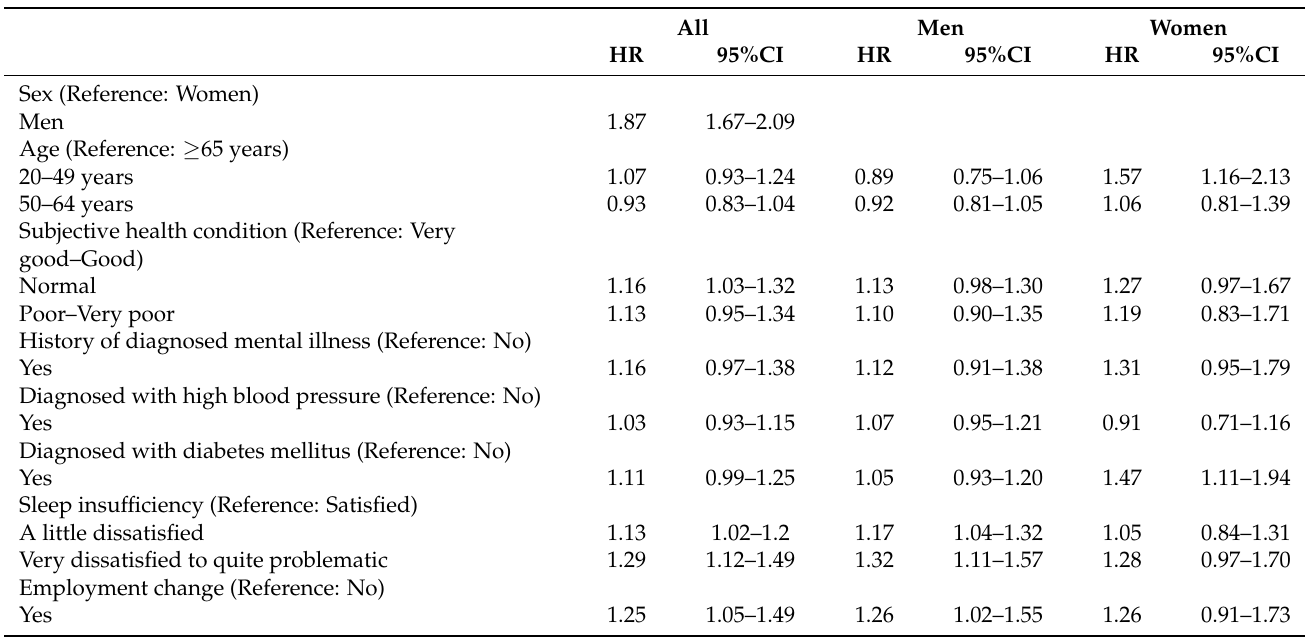
Table A3. Multivariate—adjusted hazard ratios and 95% confidence intervals for the occurrence of problem drinking from FY 2012 to FY 2017.